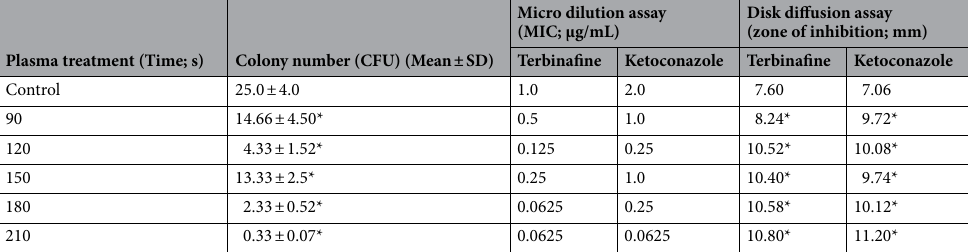
Table 1. Effect of CAP on the fungal growth and antifungal activity of terbinafine and ketoconazole against T. rubrum. *Statistically significant difference with a control (ANOVA, P < 0.05).